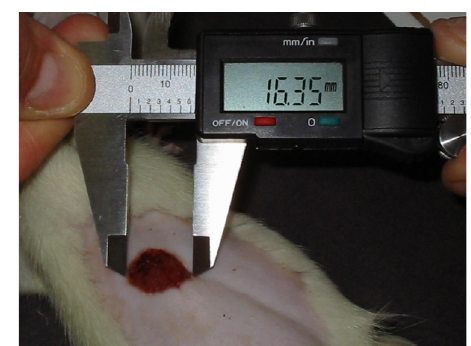
FIGURA 1 - Medição da ferida com paquímetro digital